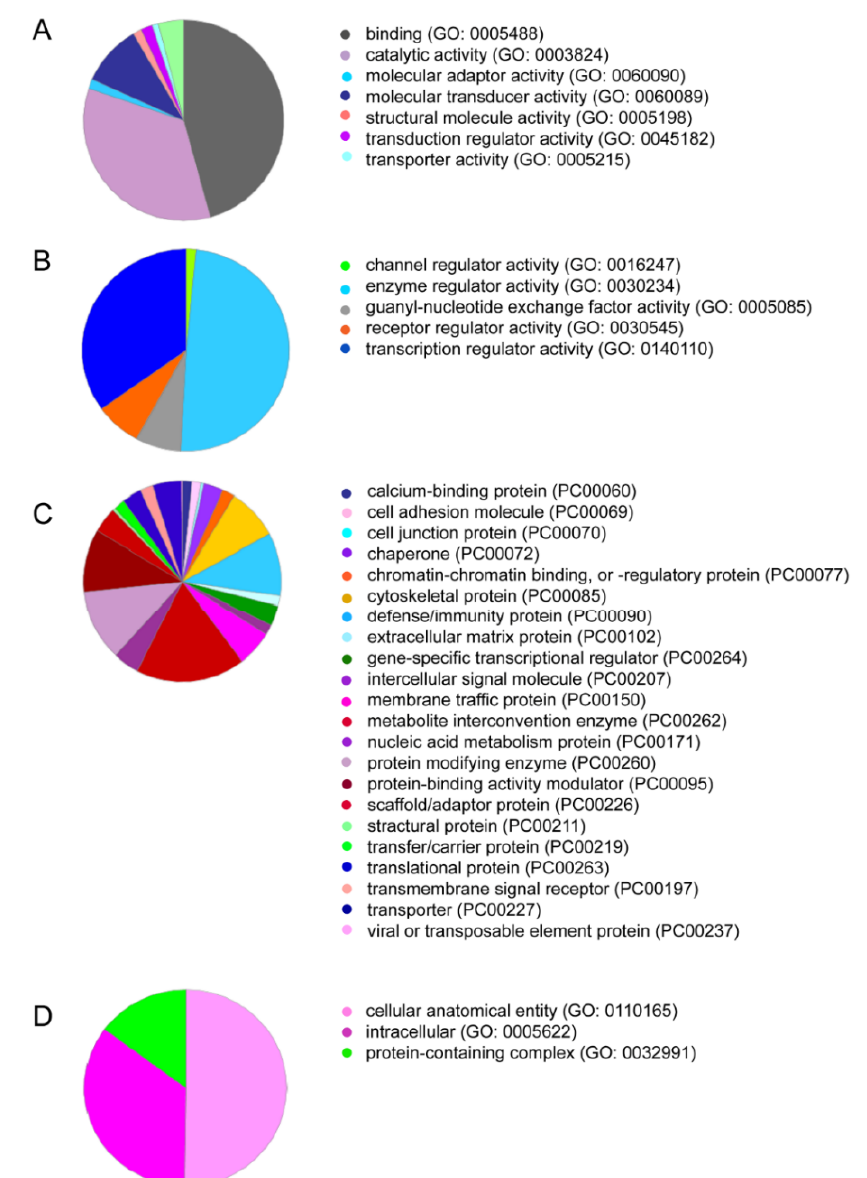
Figure 1. PRF lysates contain a large spectrum of proteins, including TGF-β1. PANTHER analysis for the protein IDs was conducted based on ( A ) molecular function, and among the sections, ( B ) molecular functional regulators including TGF-β1 are indicated. Classifications based on ( C ) protein class and ( D ) cellular components are also presented.